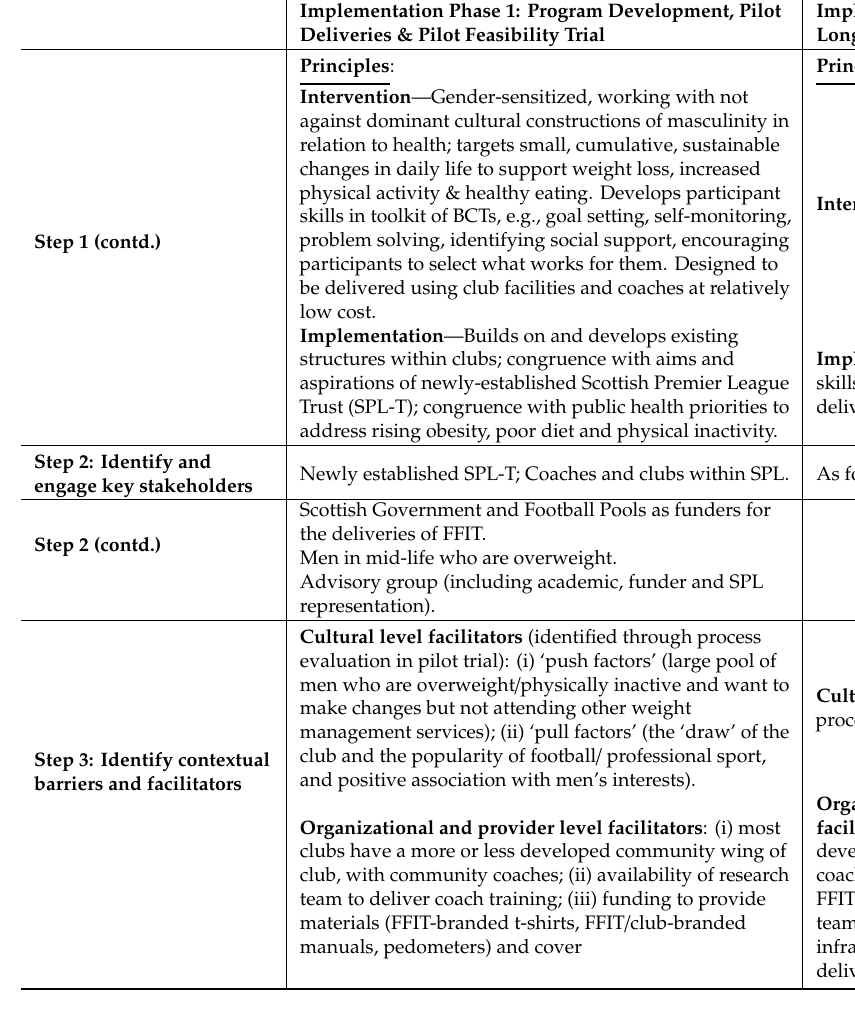
Implementation Phase 2: FFIT RCT and Long-Term Follow-Up